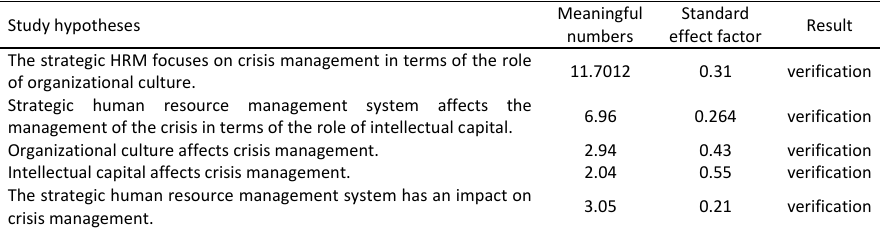
Table 3: summary of the results of the study hypotheses Table 3. summary of the results of the study hypotheses